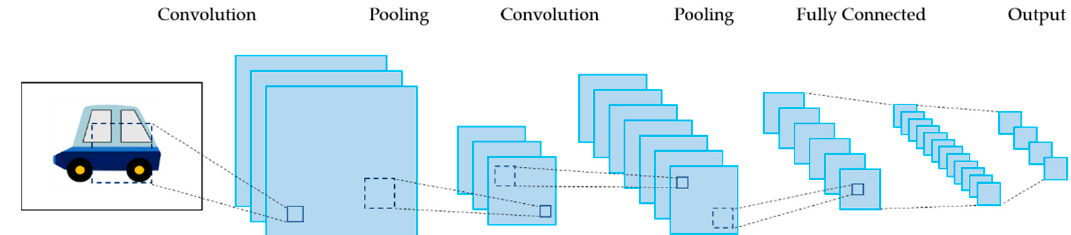
Figure 4. Scheme of the process of convolutional neural networks.